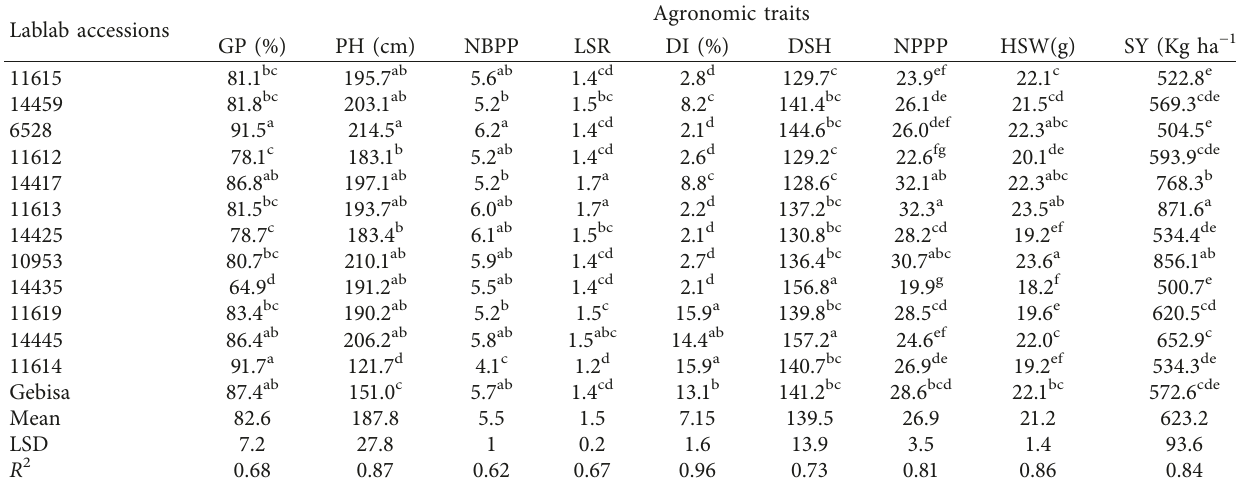
Table 12: Mean values of agronomic traits of lablab accessions combined over locations. Lablab